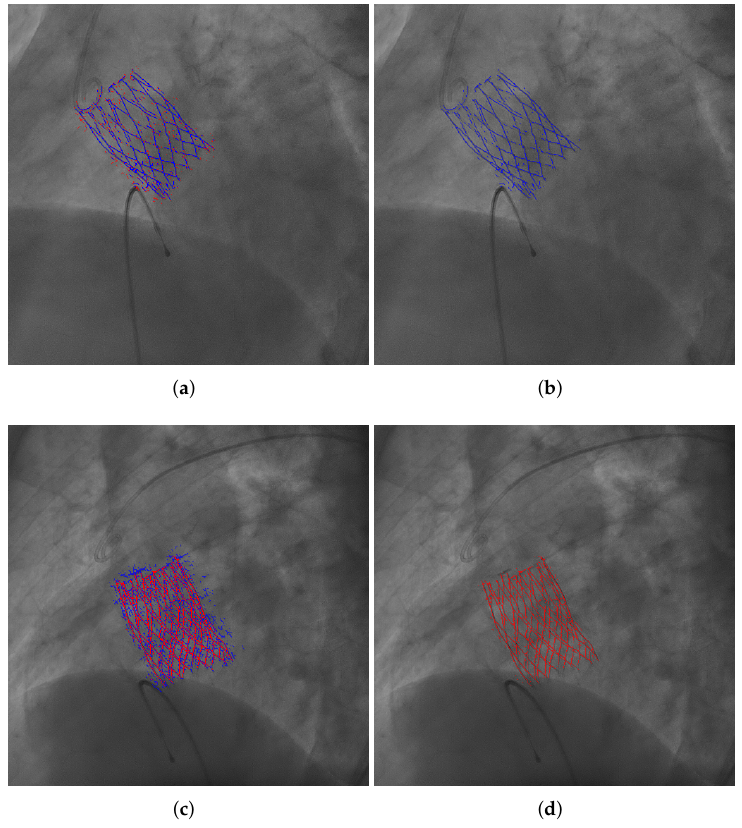
Figure 7. Examples of segmentation results obtained by different models, using Otsu’s method (blue) and PKFP (red) binarizations, overlaid on the original angiographic frames. ( a ) Segmentation obtained by the model trained with 600 frames, using cross-entropy and data augmentation disabled (13th row in Table 1), binarized using Otsu’s method and PKFP. ( b ) Same as ( a ), but with only Otsu’s method result overlaid. ( c ) Segmentation obtained by the model trained with 600 frames, using focal loss and data augmentation enabled (16th row in Table 1), binarized using Otsu’s method and PKFP. ( d ) Same as ( c ), but with only PKFP result